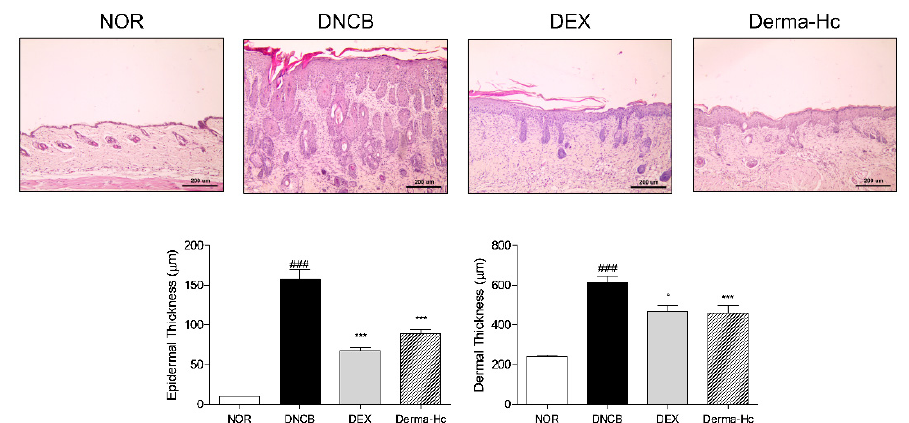
Figure 3. Derma-Hc ameliorates histological features presented in atopic dermatitis-like lesions of DNCB-induced mice. NOR, Normal saline-treated group; DNCB, 2,4-dinitrochlorobenzene (DNCB)-sensitized group; DEX, DNCB-sensitized and dexamethasone-treated group. Representative images of dorsal skin tissues were stained with H&E. Blue, cell nuclei; Pink, extracellular matrix and cytoplasm. The thickness of epidermis and dermis was measured after tissue sections were observed under a microscope (magnification 100 × , scale bar 200 µ m). The data are presented as mean ± standard error of the mean. ### p < 0.001 compared to the NOR group. * p < 0.05 and *** p < 0.001 compared to individual groups.